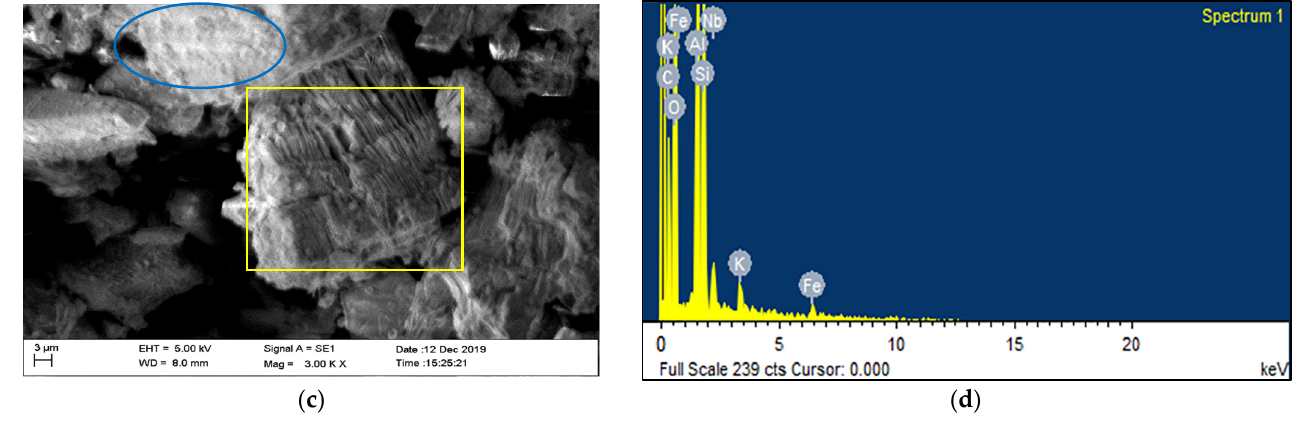
Figure 13. EDS analysis of Kumbashi sample; ( a ) elements weight (%), ( b ) atomic weight (%), ( c ) SEM image, ( d ) spectrum image.